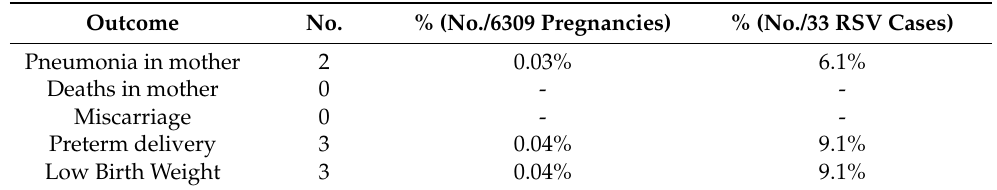
Table 3. Summary of collected outcomes of RSV cases in pregnancies. Data on studies reporting on maternal episodes in both hospitalized and non-hospitalized women were summarized [51,53,54].